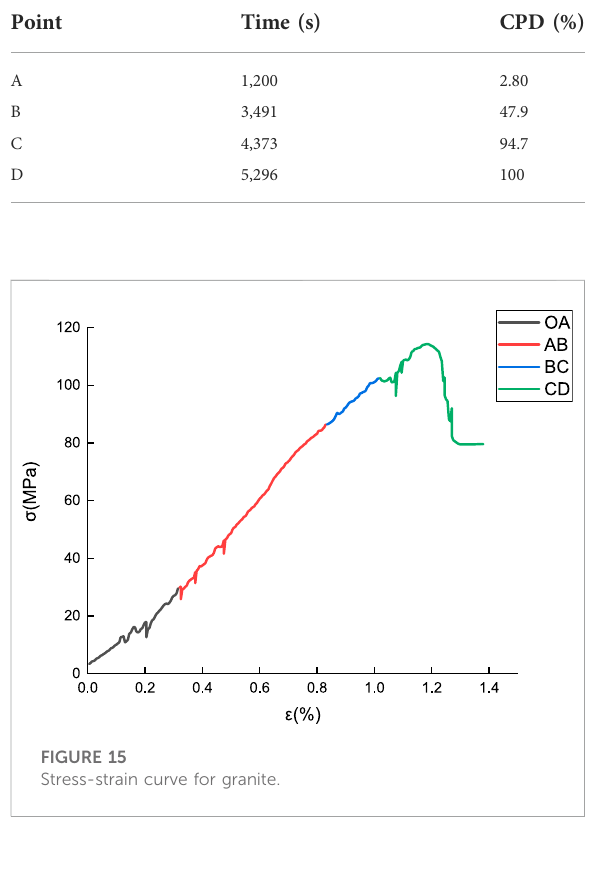
FIGURE 15 Stress-strain curve for granite.